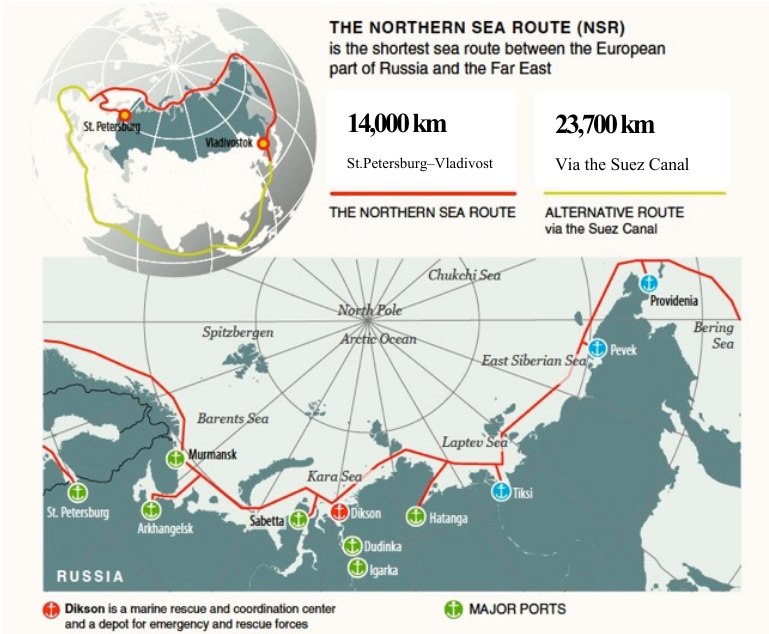
Figure 1. The line and main ports of the Northern Sea Route. Source: The NSR administration website [44].